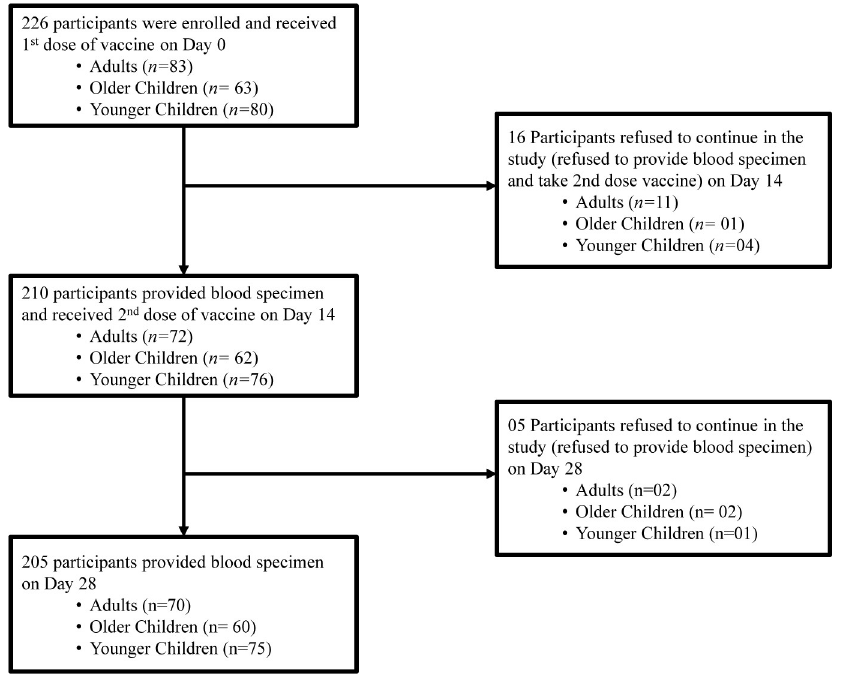
Fig 2. Flowchart of participants in the